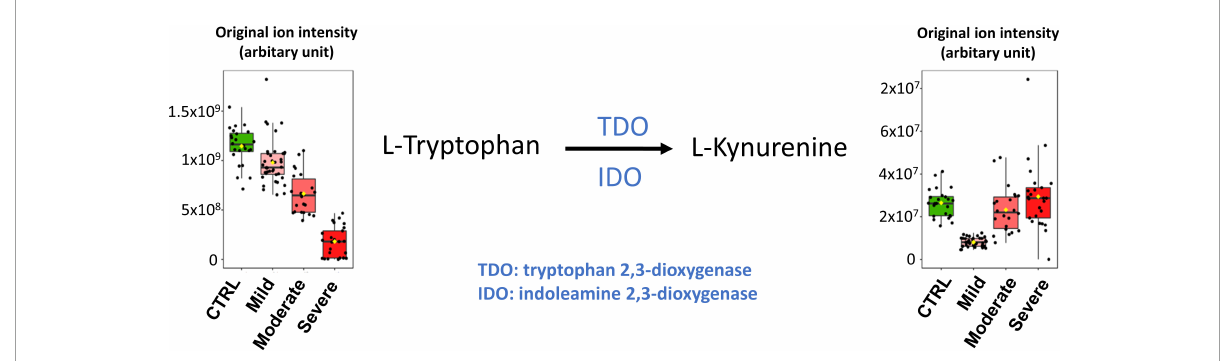
FIGURE6 Venn diagram of significantly altered pathways in samples from healthy control subjects compared to SARS-CoV-2 infected subjects (CTRL vs. All), healthy control subjects compared to mild SARS-CoV-2 infected subjects (CTRL vs. Mild) and mild SARS-CoV-2 infected subjects compared to moderate and severe COVID-19 patients (Mild vs. Moderate and Severe). A value of p < 0.05 was considered